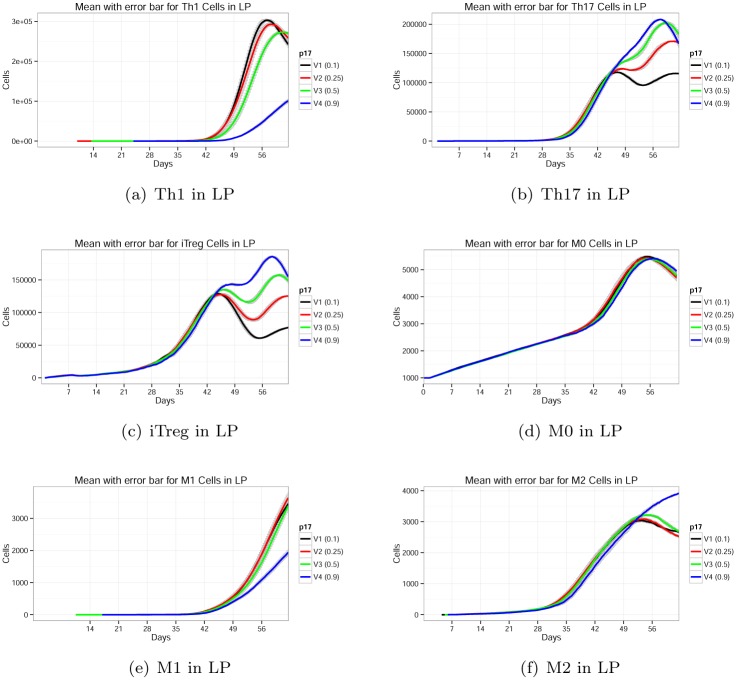
Effect of parameter p
17 on Th1, Th17, iTreg, M0, M1, and M2 phenotypes.